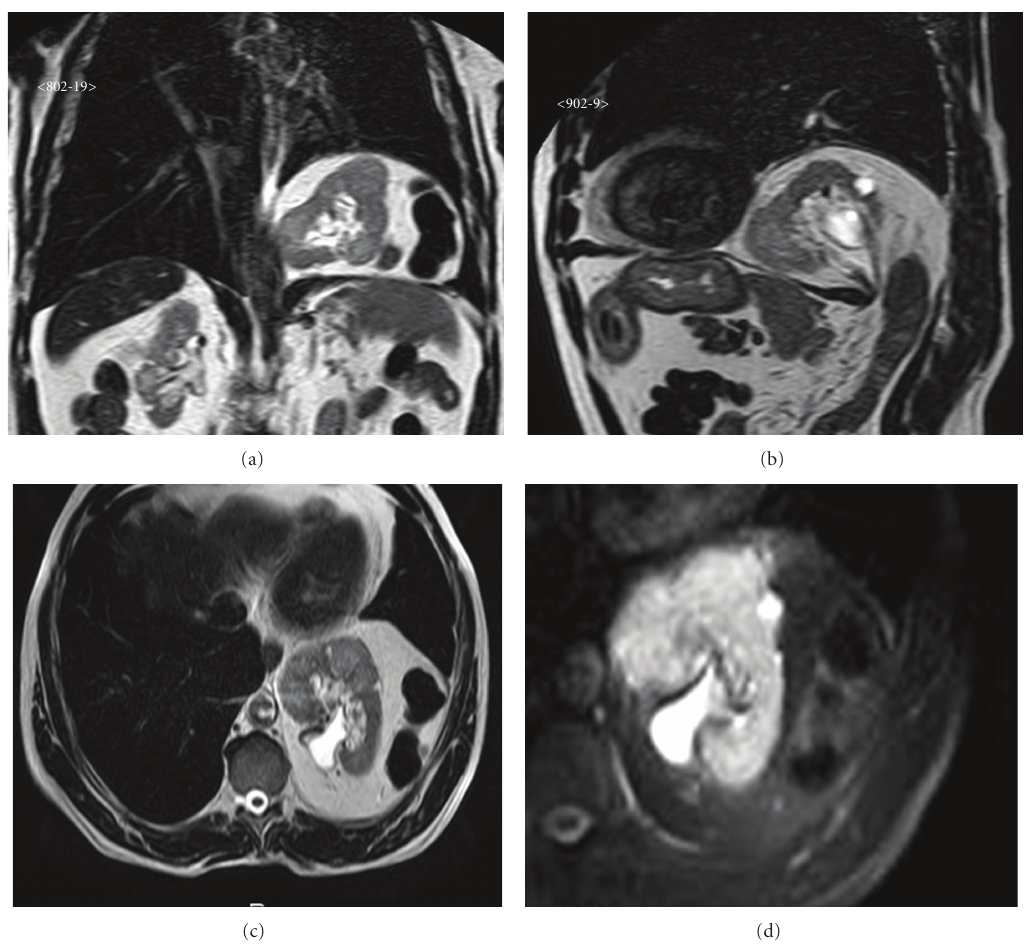
Figure 4: Magnetic resonance imaging (MRI). (a) T2 sequence on coronal view. (b) T2 sequence on sagittal plane. (c) T2-weighted image on axial plane. (d) Particular of left kidney on T2 axial view with fat